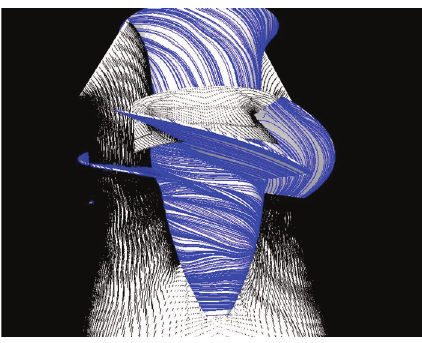
Figure 10: Smearlines and velocity vectors for 52rad / s.